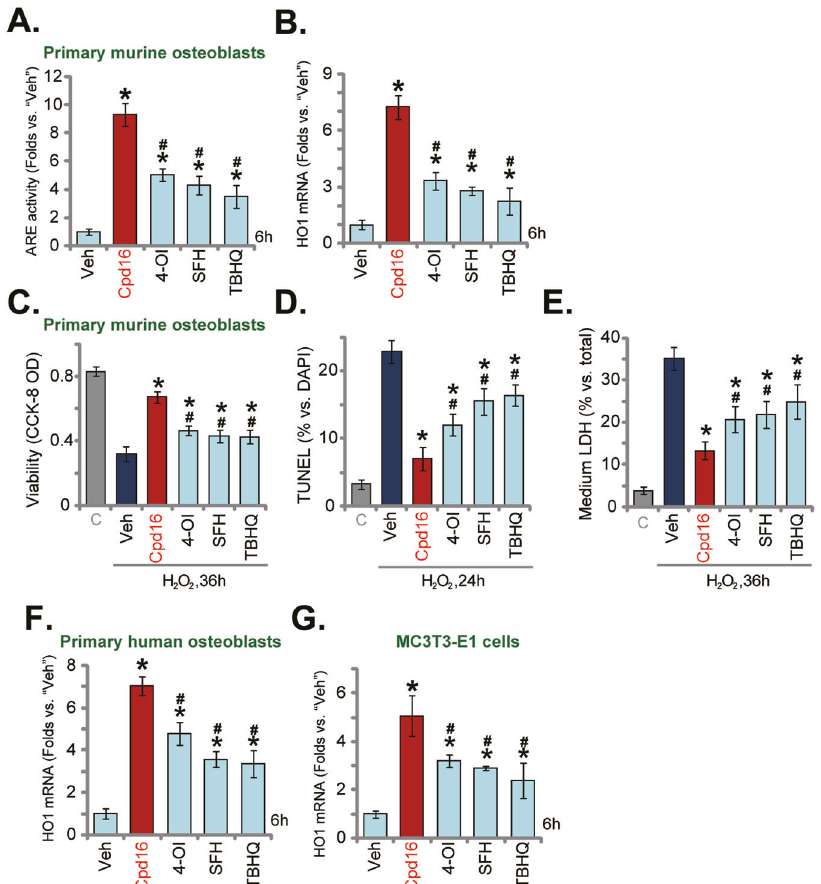
Fig. 4 Cpd16-induced Nrf2 activation and osteoblasts protection against H 2 O 2 were stronger than other known Nrf2 activators. The primary murine osteoblasts ( A , B ), human osteoblasts ( F ), and MC3T3-E1 murine osteoblastic cells ( G ) were treated with 25 μ M of Cpd16, Sulforaphane (SFH), 4-octyl itaconate (4-OI), tert-butylhydroquinone (TBHQ), and cultured for 6 h, the relative ARE activity ( A ) and HO1 mRNA ( B , F , G ) expression were tested. The primary murine osteoblasts were pretreated with 25 μ M of Cpd16, SFH, 4-OI, or TBHQ for 2 h, followed